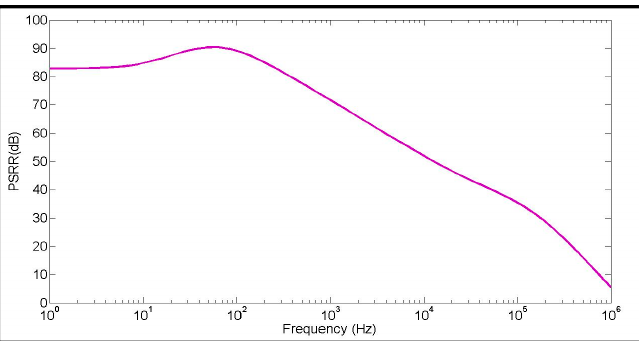
Figure 12. The power supply rejection ratio (PSRR).